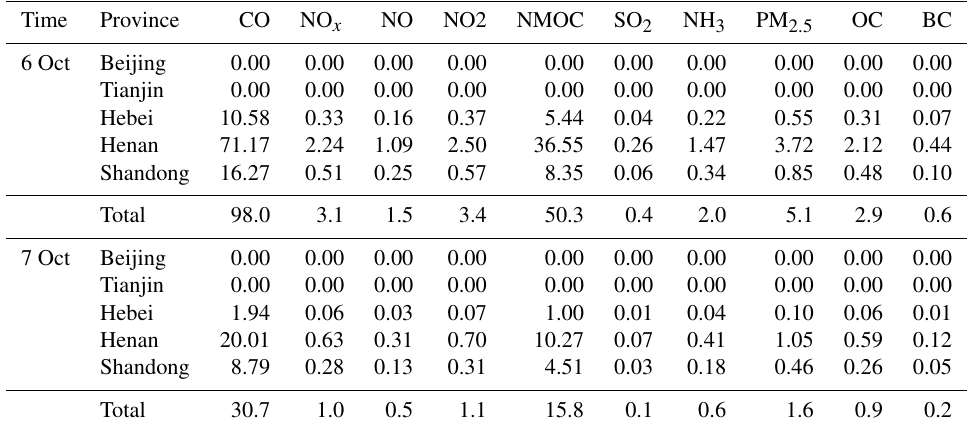
Table 4. The emissions (Ggday − 1 ) of gaseous and particulate species from crop field burning on 6 and 7 October in NCP region, including the provinces of Beijing, Tianjin, Hebei, Henan and Shandong. Time Province CO NO x NO NO2 NMOC SO 2 NH 3 BC 6 Oct